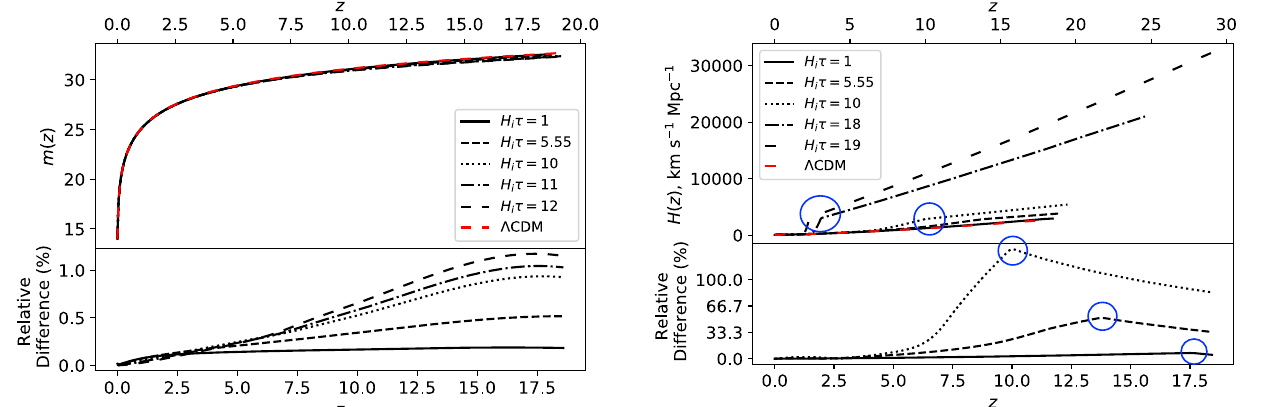
Fig. 4 The evolution of the apparent magnitude m ( z ) of Type Ia super- novae. Here, we have assumed that the absolute magnitude takes the value M = − 19 . 3 and H 0 is given by the Planck 2018 estimate. Shown on the bottom plot is the relative difference between time-delayed cos- mology and Λ CDM, which is used as the reference. Time-delayed cos- mology is virtually indistinguishable from Λ CDM